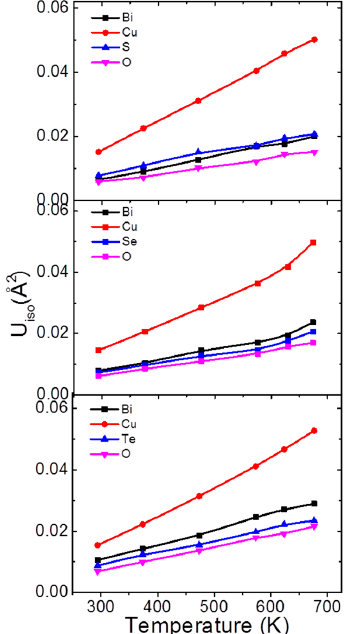
Figure 6. ADPs for BiCuMO (M = S, Se, Te) as a function of temperature. Reproduced with permission from Reference [48]. Copyright 2015, The American Royal Society of Chemitry.